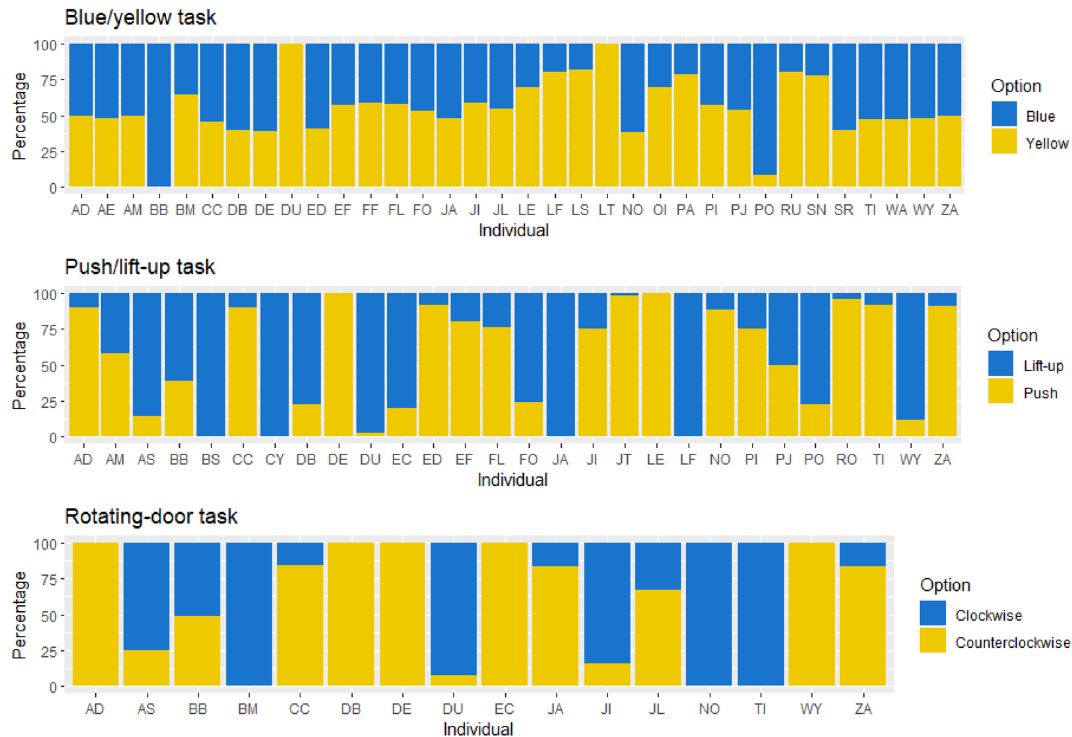
Figure 2. Percentage of options that each individual of a group of Barbary macaques ( Macaca sylvanus ) at Trentham Monkey Forest (UK) used to solve each task. Each bar represents the proportion (in percentage) each individual used each of the two options available in each task, with yellow representing one of the options and blue representing the alternative